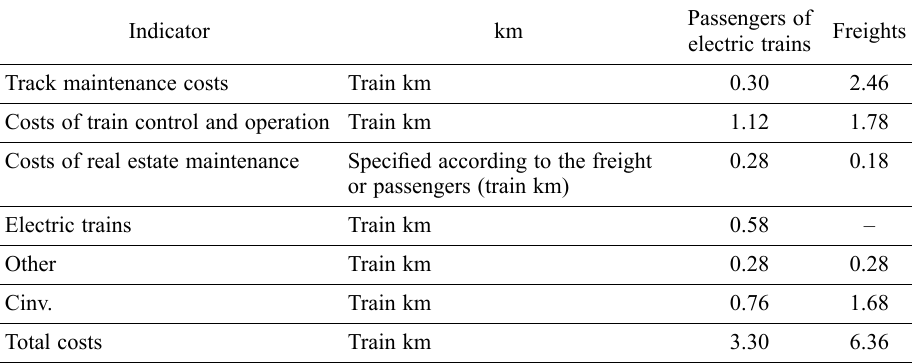
Table 2 . An example of calculation of charges for using infrastructure for category 1